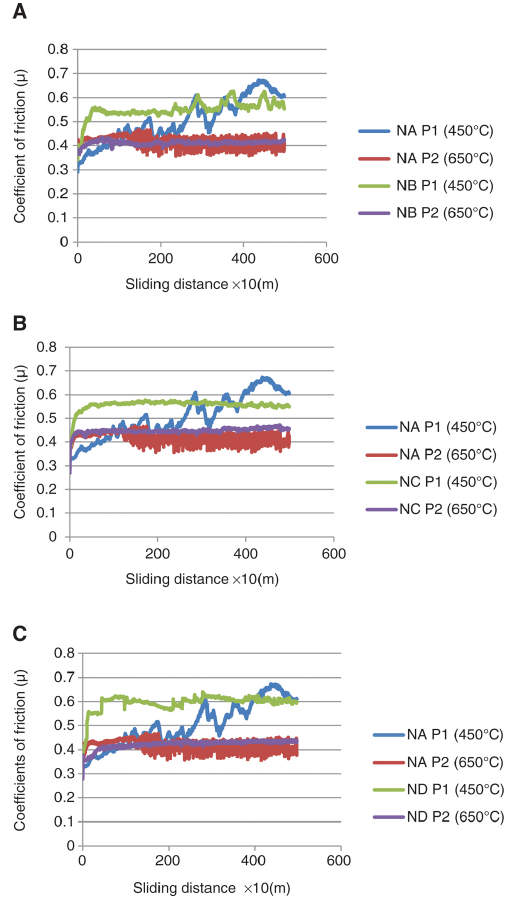
Figure 5: The four sections (A – D) taken by the optical profiler of each track spaced apart by 90° for measuring the average used